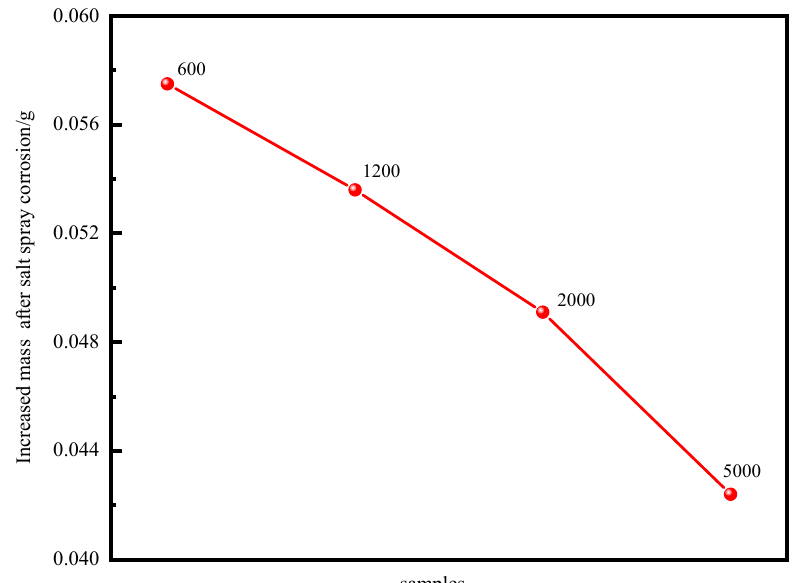
Figure 10. Mass change in samples with different roughness after neutral salt spray corrosion .